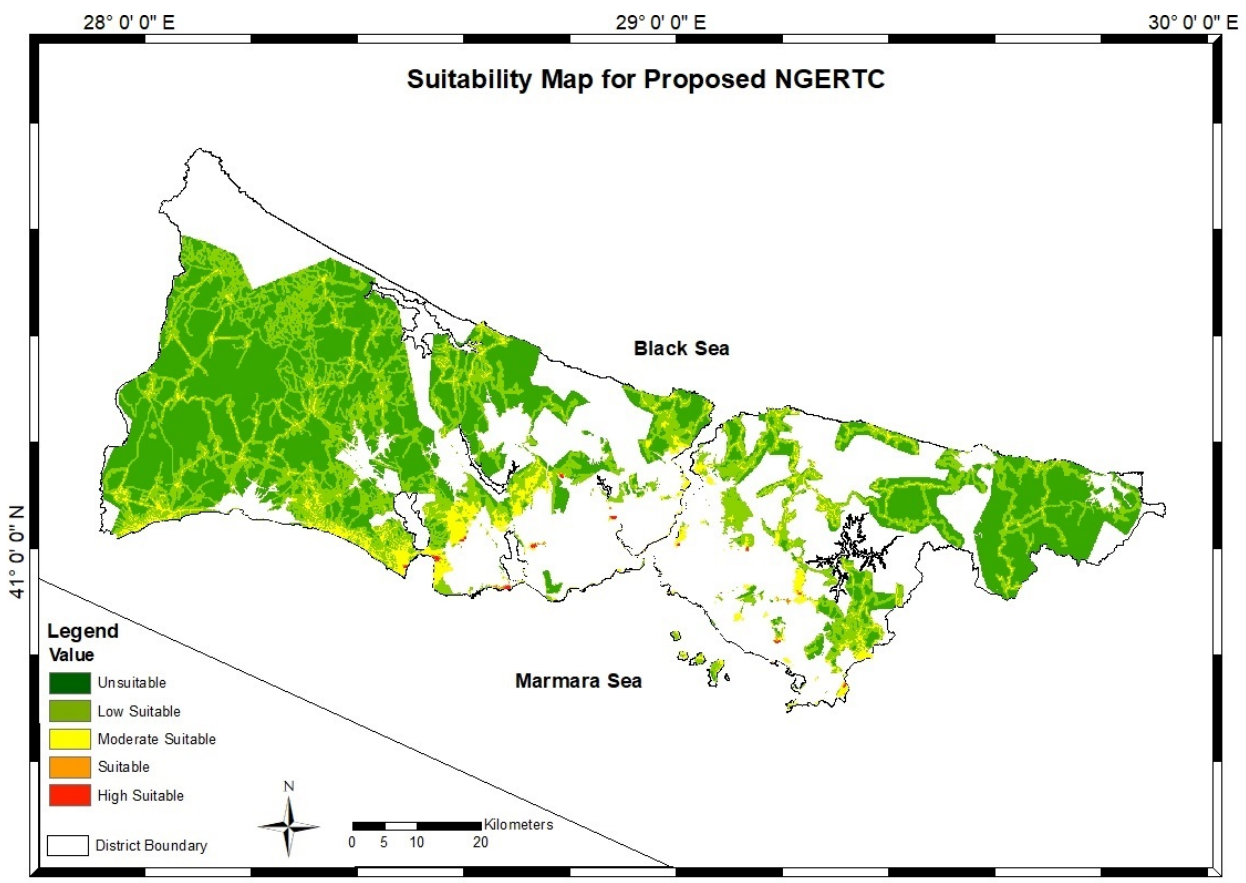
Figure 12. Existing NGERTC 15 min coverage areas.